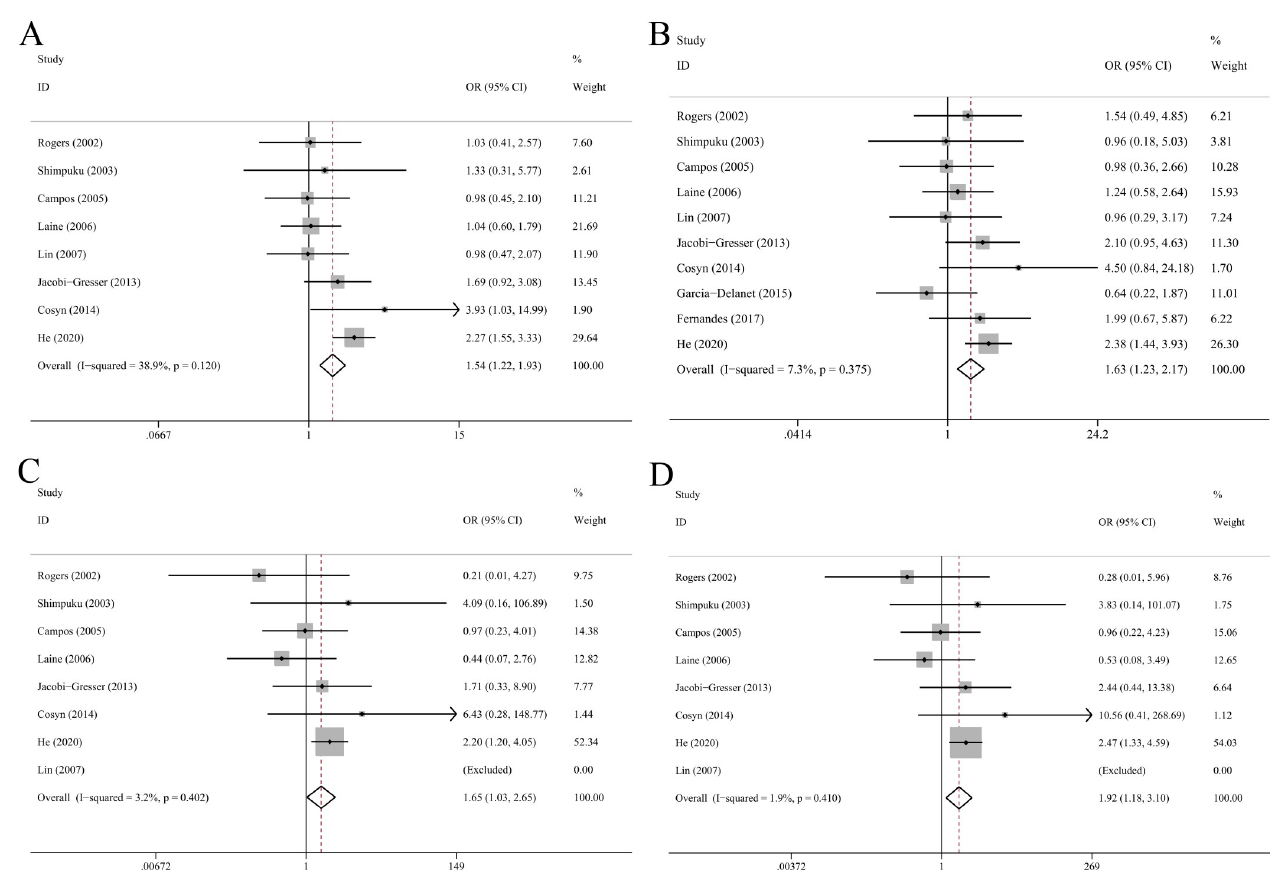
Fig 2. Forest plots of IL-1 α C-889T polymorphism with peri-implant disease risk in allelic (A), dominant (B), recessive (C) and homozygote model (D).